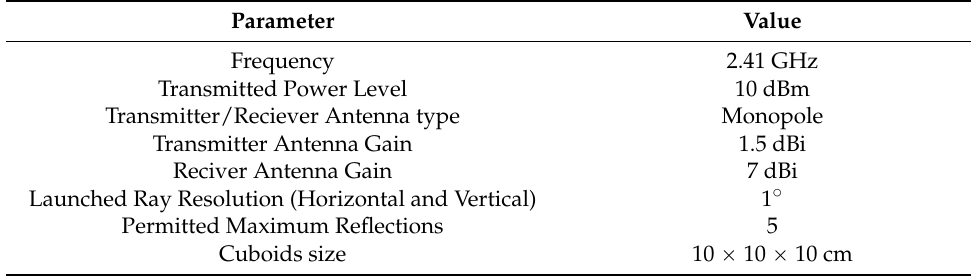
Table 2. 3D ray launching simulation